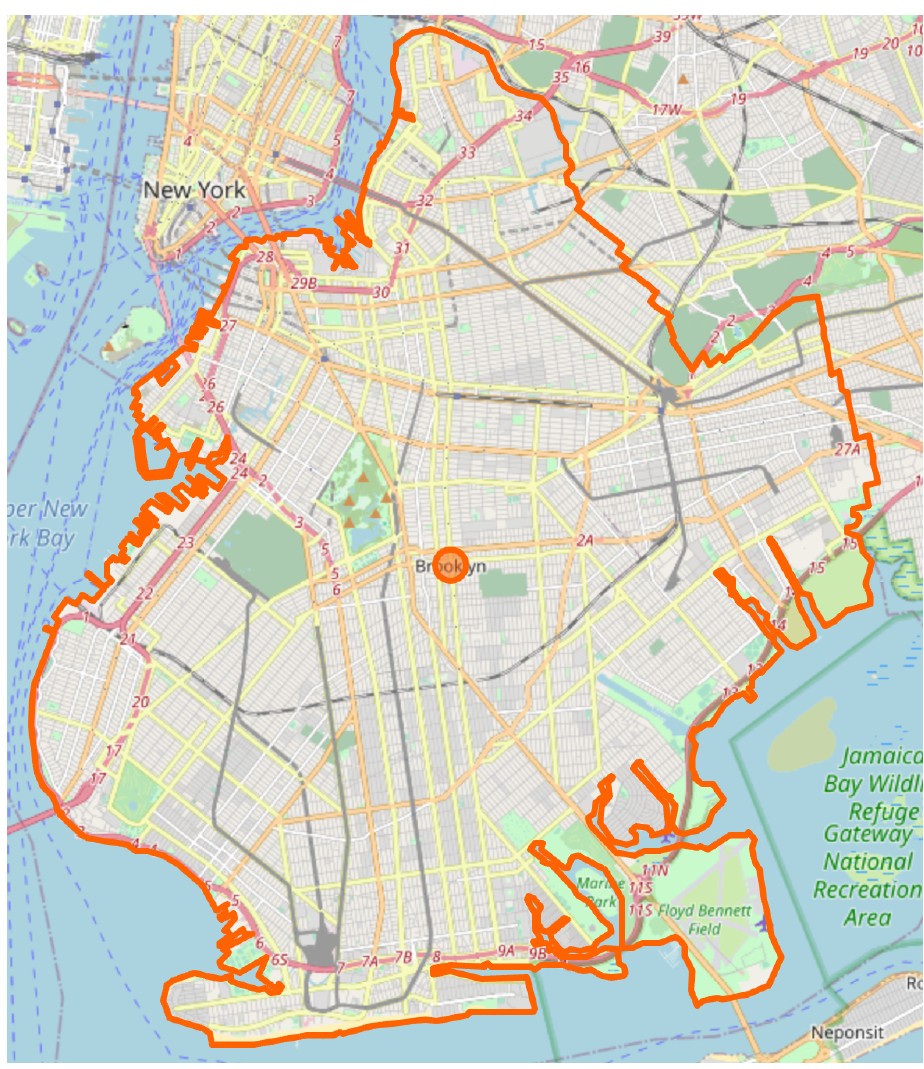
Figure 14. Open Street Map for Brooklyn, New York,